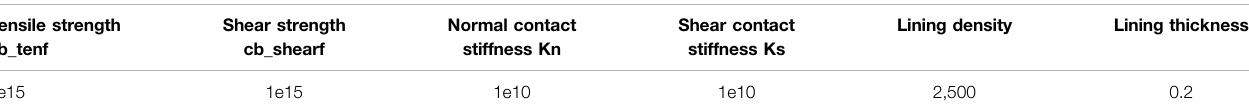
TABLE 2 | Microscopic parameters of tunnel lining.